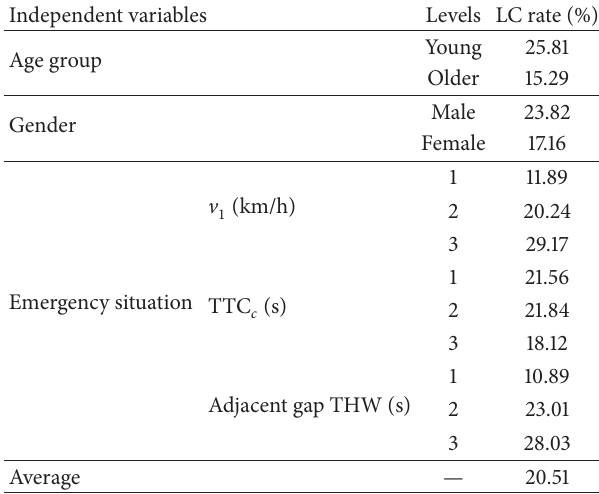
Table 1: Experiment design: impact factor levels. Table 2: Maneuver decision results (mean